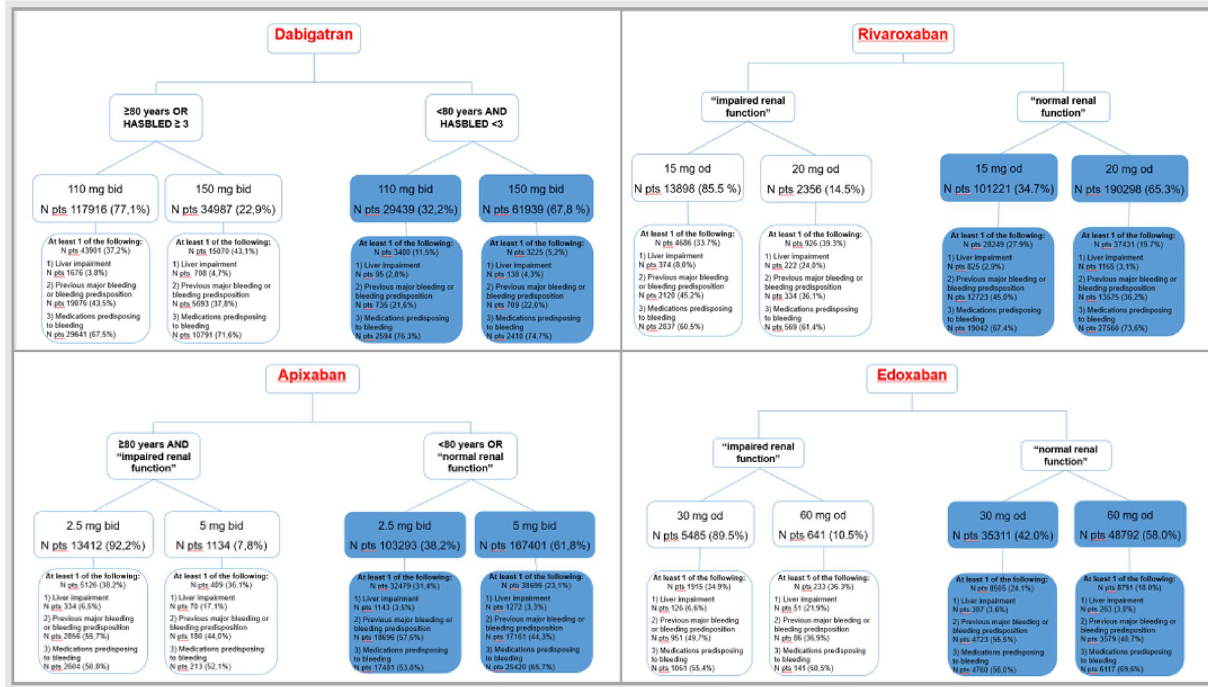
Figure 4. Proportion of patients on standard or adjusted dose on the base of the baseline characteristics potentially influencing the dose choice among 927,523 NOAC treatments in AIFA